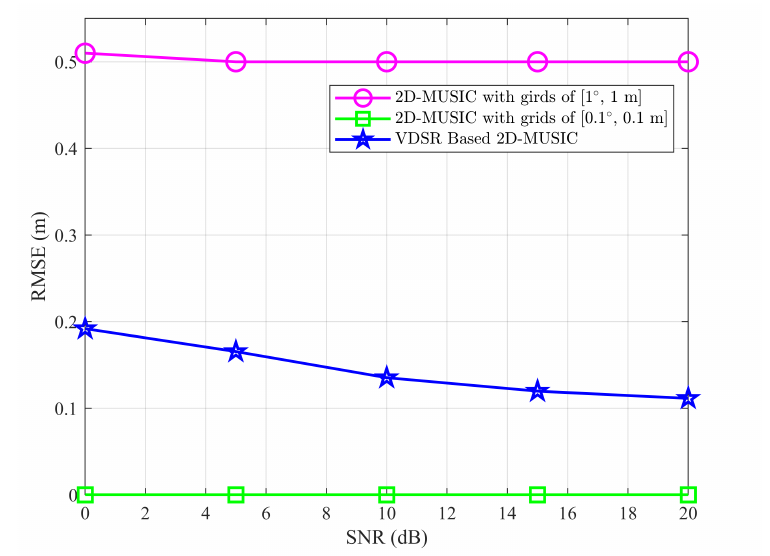
Figure 6. RMSE of DOA versus SNR.